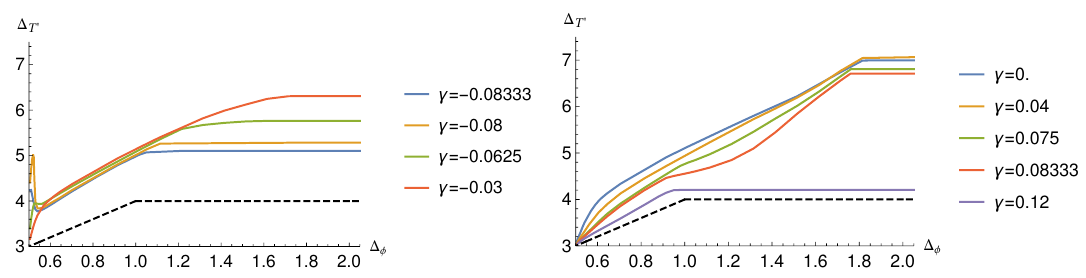
Figure 7 . Bound on the dimension of the first neutral parity-even spin-2 operator after the stress tensor as a function of ∆ φ . Different curves corresponds to different values of the parameter γ defined in (2.12). The dashed curves correspond to the function min (4 , 2∆ φ + 2) . The bounds have been obtained at Λ = 13